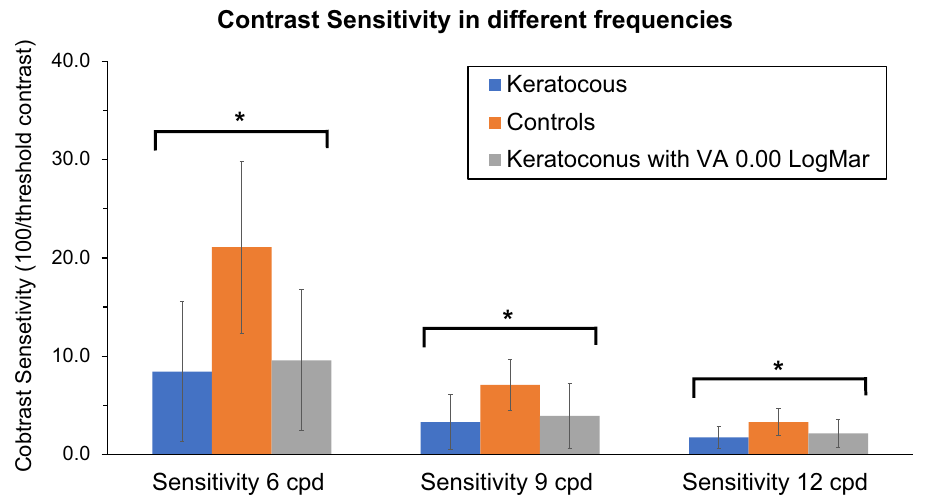
Figure 1. Contrast Sensitivity in different frequencies for keratoconus group, keratoconus subjects with visual acuity of 0.00 LogMar and for control group. Blue bars represent contrast sensitivity for keratoconus subjects, orange bars represent contrast sensitivity for keratoconus subjects with visual acuity of 0.00 LogMar and gray bars represent contrast sensitivity for Control subjects. *Significant level of < 0.005. The figure was generated using Microsoft 365 Excel Version 2103 and the resolution adjusted using Microsoft 365 PowerPoint Version